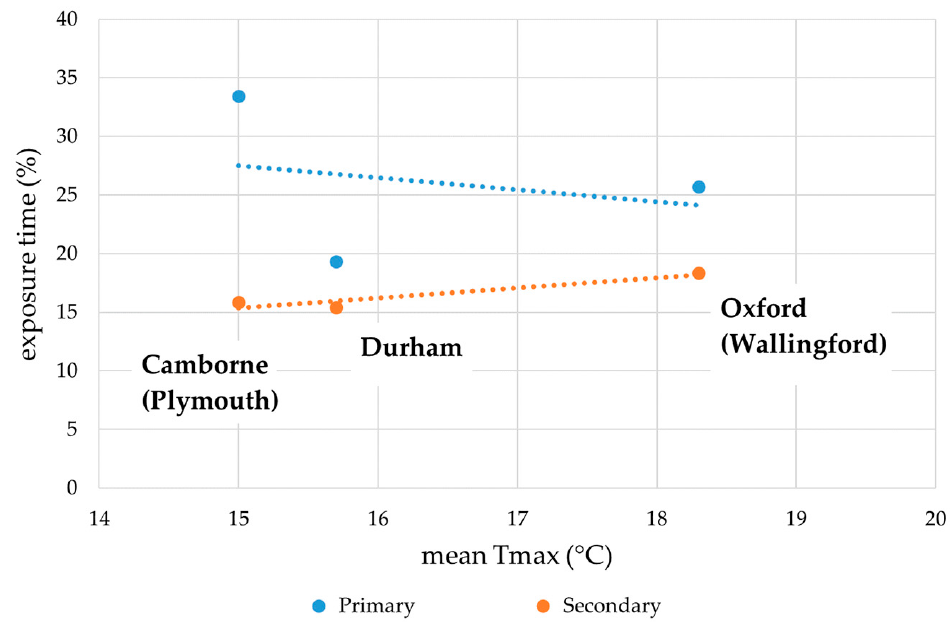
Figure 2. Exposure time (calculated as a weighted mean of weekday and weekend exposure) of primary and secondary school students (data base: [87]) over the mean daily maximum temperature in Camborne, Durham and Oxford, April to July 1994 [UK Metoffice].